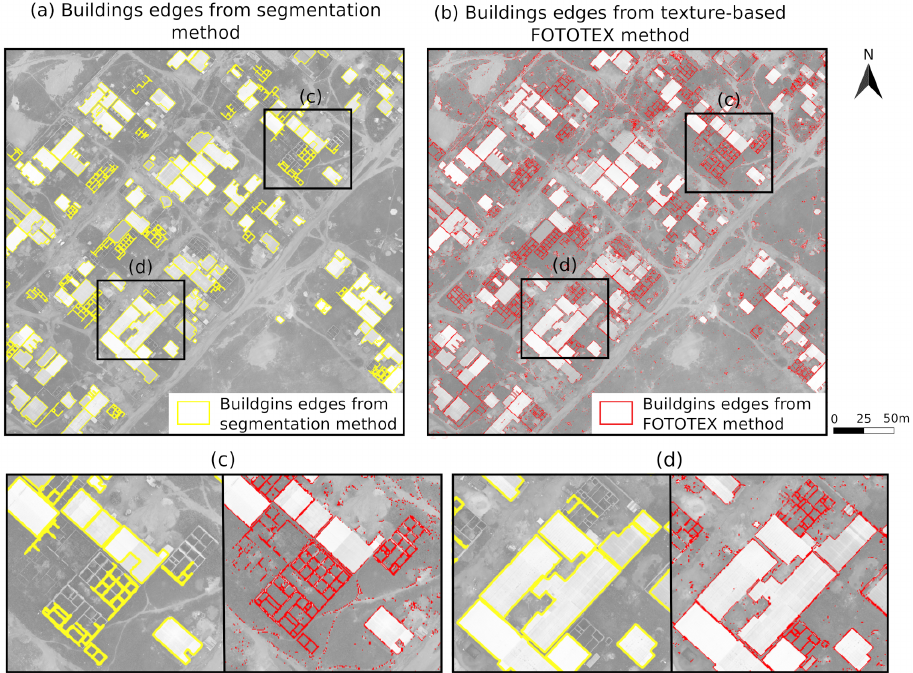
Figure 13. Extraction of buildings edges with ( a ) a segmentation method carried out with the Large Scale Generic Region Merging algorithm (Orfeo Toolbox) and ( b ) the FOTOTEX method implemented on the blue band of UAV image. ( c , d ) zooms on two different areas to compare detection by FOTOTEX and